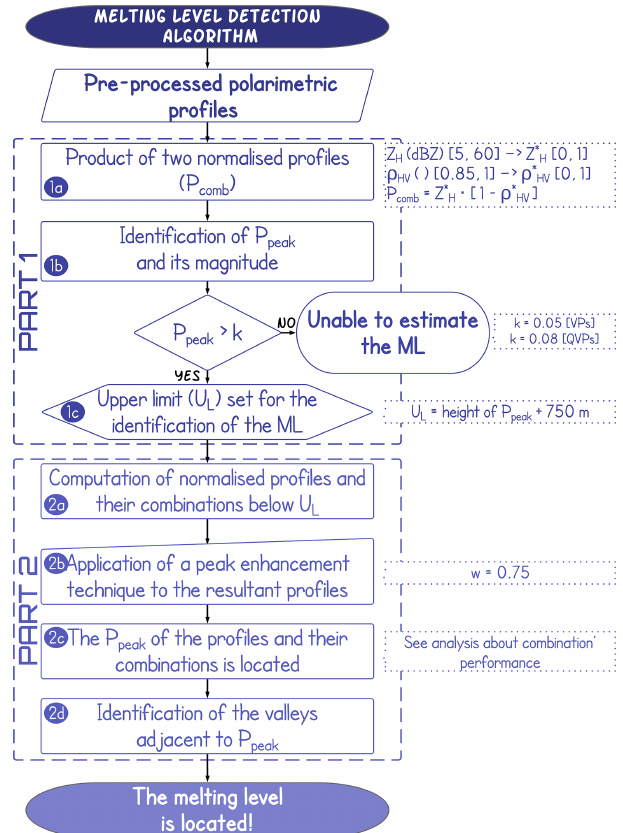
Figure 4. Flow chart of the proposed